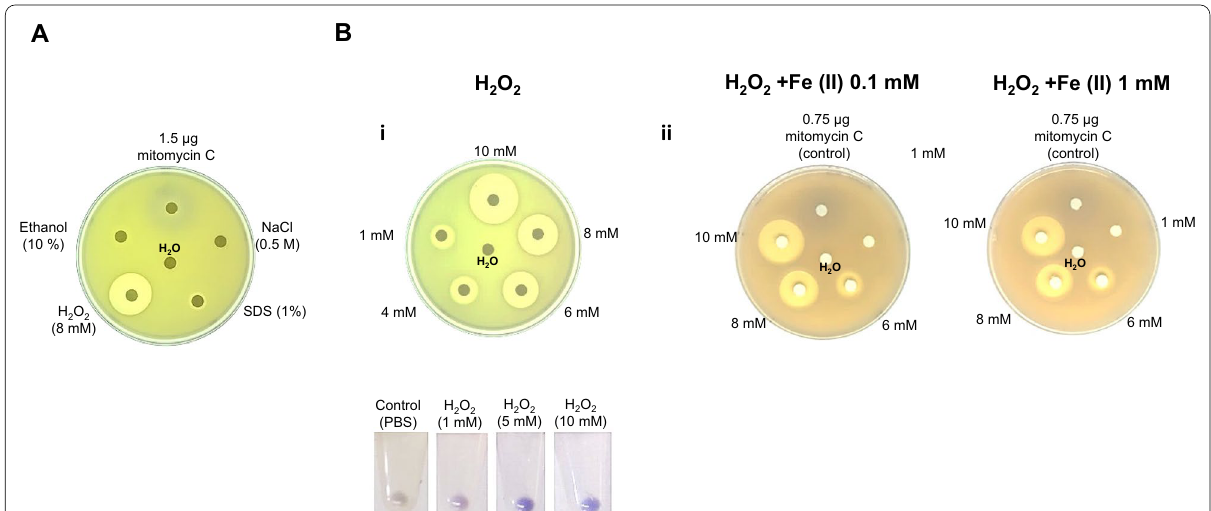
Fig. 3 Reporter strain specificity test. A shows the effect of osmotic, membrane, oxidative, and protein stress (clockwise) using NaCl, SDS, H 2 O 2, and ethanol as the corresponding perturbing agents at the indicated concentration. B shows the effect of different concentrations of H 2 O 2 . i shows the effect of H 2 O 2 without iron in the media, lower panel shows the transitory activation of the reporter strain after a 30‑min exposure to different concentrations of H 2 O 2 . ii shows the effect of two concentrations of iron in the media and the effect of exposure to H 2 O 2 at different concentrations emulating a Fenton reaction. The iron present in the media is indicated at the bottom of each image. The clear area on each experiment indicates cell death. The purple halos indicate reporter strain